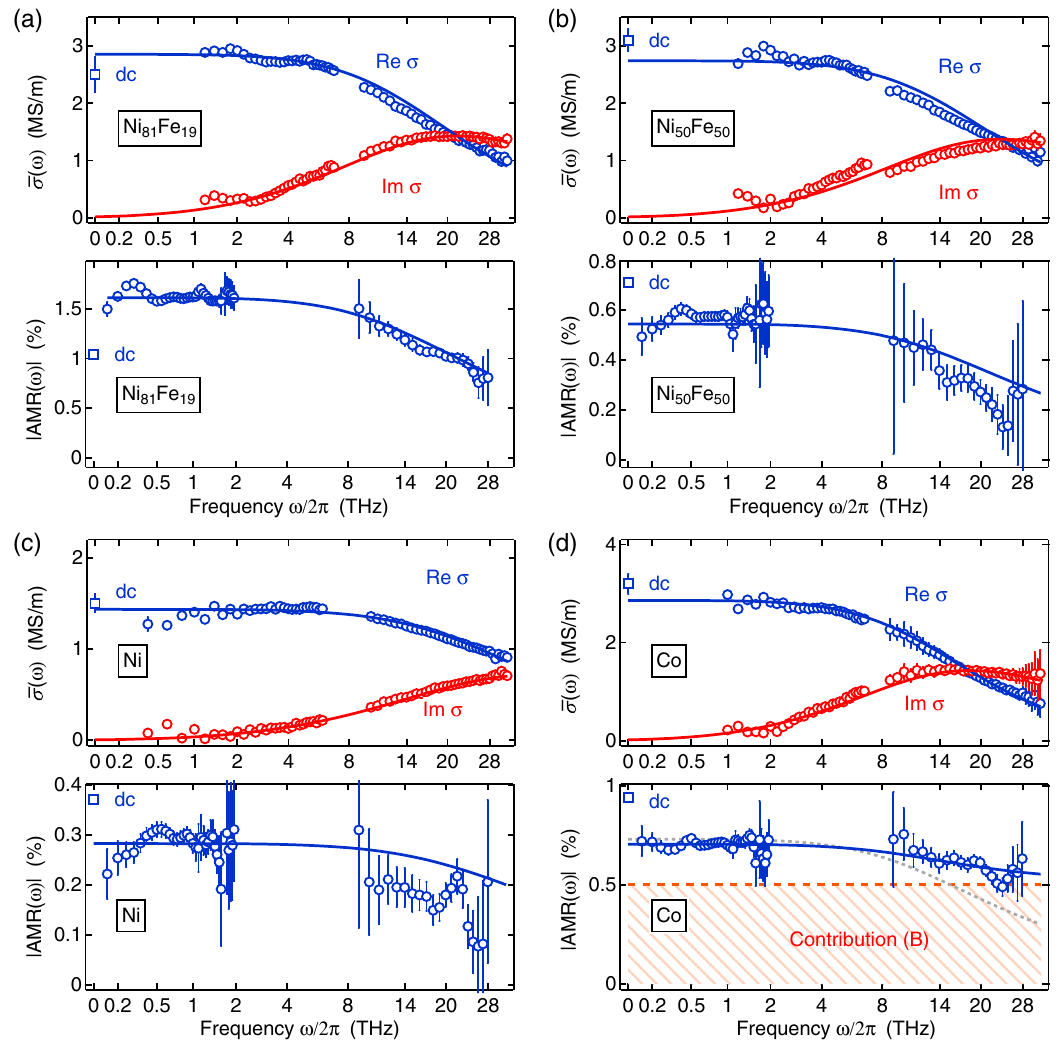
FIG. 3. Mean conductivity and AMR contrast from dc to 28 THz. (a) Mean complex-valued conductivity ¯ σ ¼ ð σ k þ σ ⊥ Þ = 2 (upper panel) and magnitude j AMR j of the AMR contrast (lower panel) of the Ni 81 Fe 19 thin film as a function of frequency. Solid lines are fits based on the Drude formula [Eqs. (2) and (3)]. The dc values are shown at ω ¼ 0 (square symbol). (b) – (d) Same as panel (a), but for Ni 50 Fe 50 , Ni, and Co, respectively. In panel (d), the red dashed line and shaded area indicate the intrinsic contribution (B) with amplitude B ¼ 0 . 5 % to AMR. For comparison, the grey dotted curve shows a fit using Eq. (3) without an intrinsic contribution ( B ¼ 0 ). For clarity, the scaling of the frequency axis is nonlinear ( ∝ ω − 1 = 4 ). It is linear in Fig. S7 of Ref. [41]. The measured frequency ranges are determined by the spectral coverage of the THz emitter-detector configurations used, and they differ for ¯ σ and j AMR j (see Sec. III. B). The error bars of the THz data indicate their precision as estimated from repeated measurements (for ¯ σ ) and the spectral noise floor [for j AMR j , see Figs. 2(c) and 2(d)]. The overall scaling of j AMR j is accurate within an estimated uncertainty of 30% (see Appendix